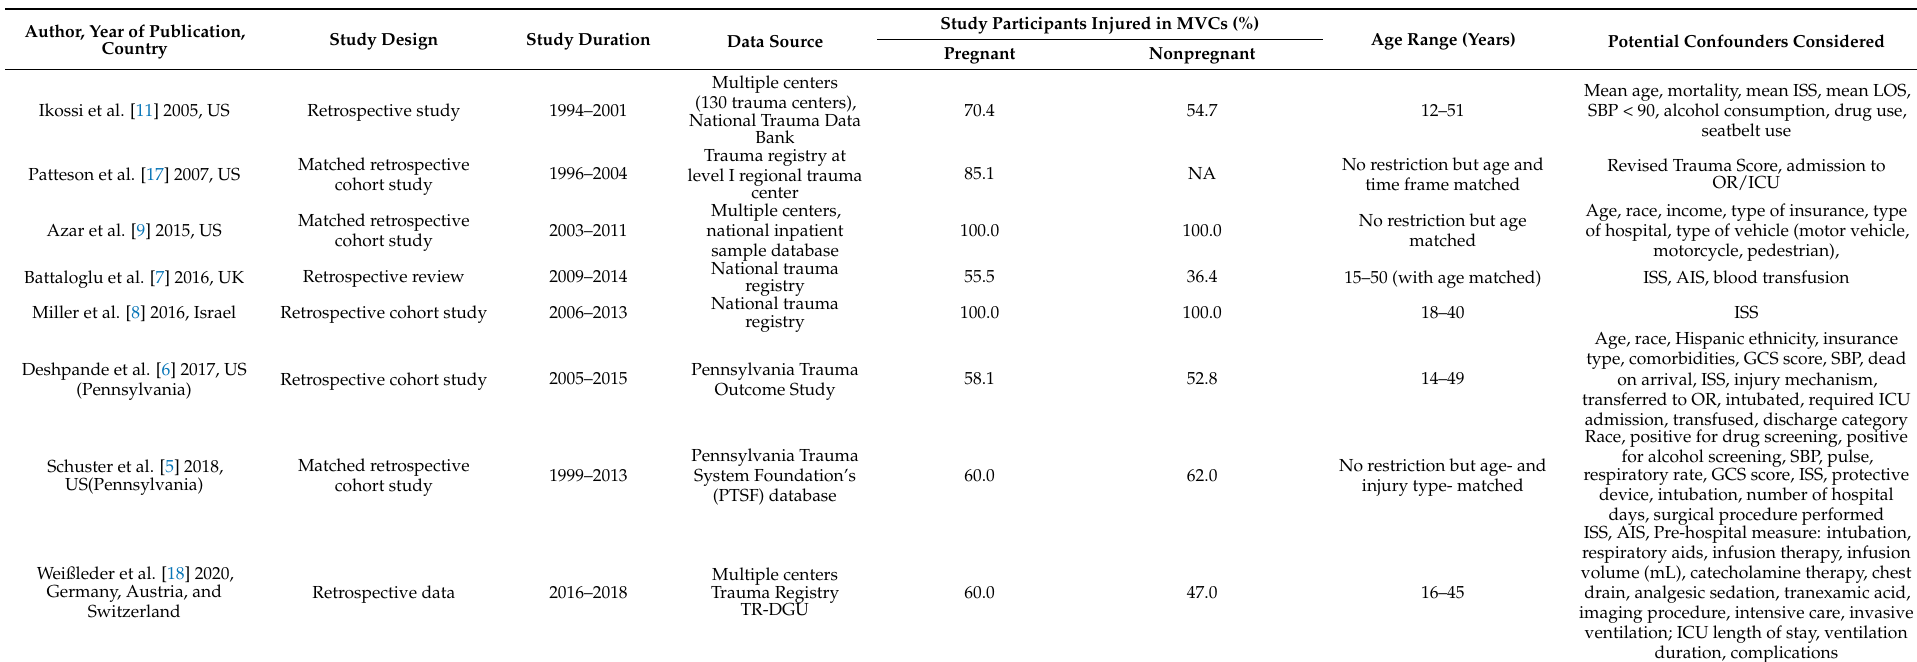
Table 1. Characteristics of studies included